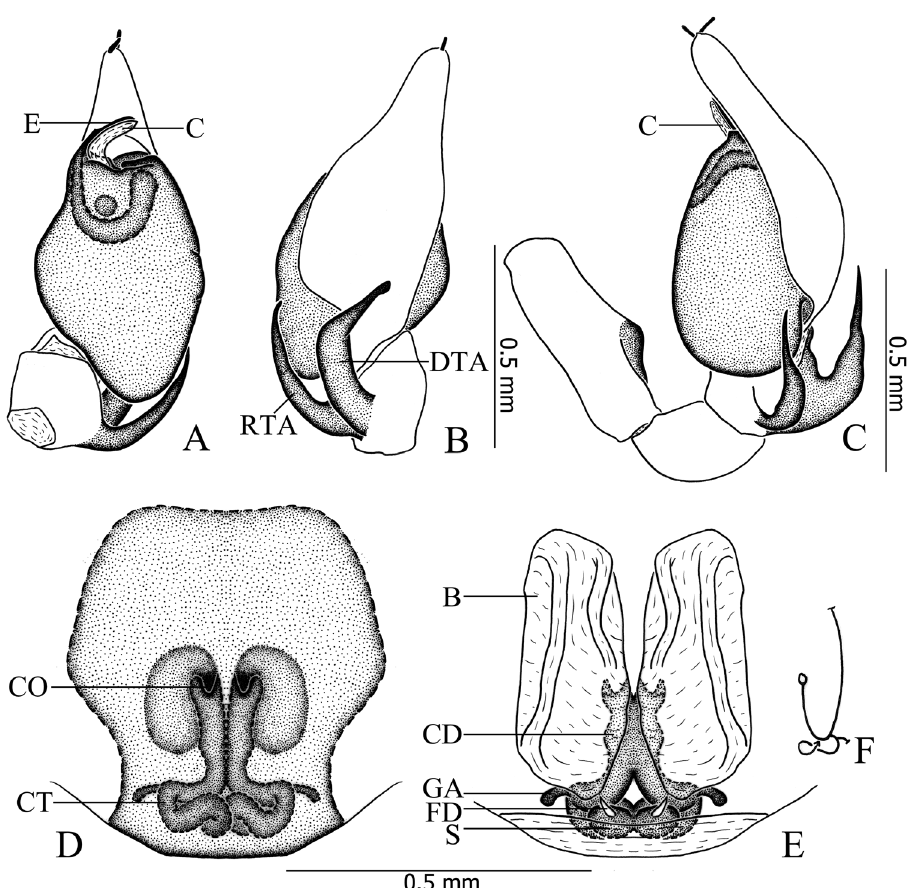
Figure 9. Otacilia curvata sp. n. A left male palp, ventral view B same, dorsal view C same, retrolateral view D epigyne, ventral view E vulva, dorsal view F schematic course of internal duct system. Scale bars equal for A and B , equal for D and E